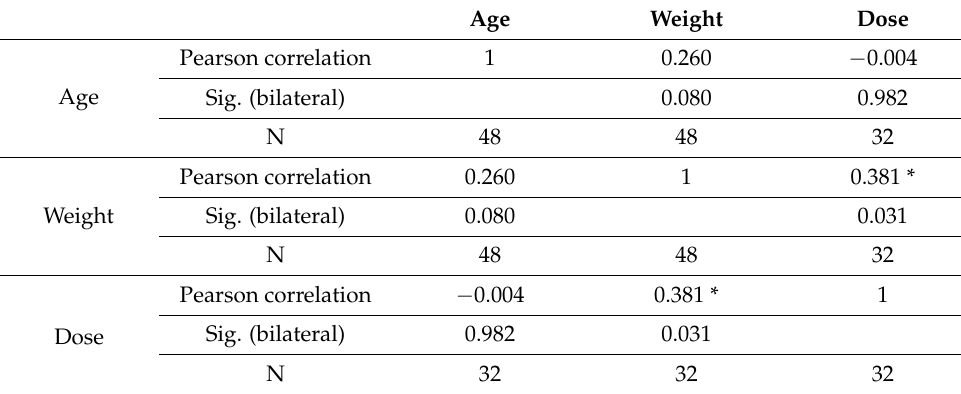
Table 3. Correlations between age, weight, and dose.